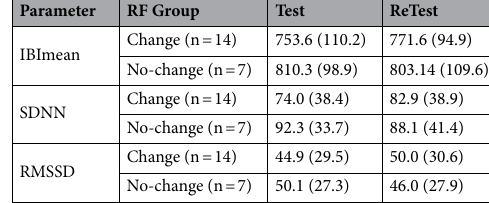
Table 1. HRV parameters [means (SD)] in Test and Retest for the two groups formed according to the RF change between the Test and the Retest: "RF Change" (n = 14), and “RF no-change” (n = 7).